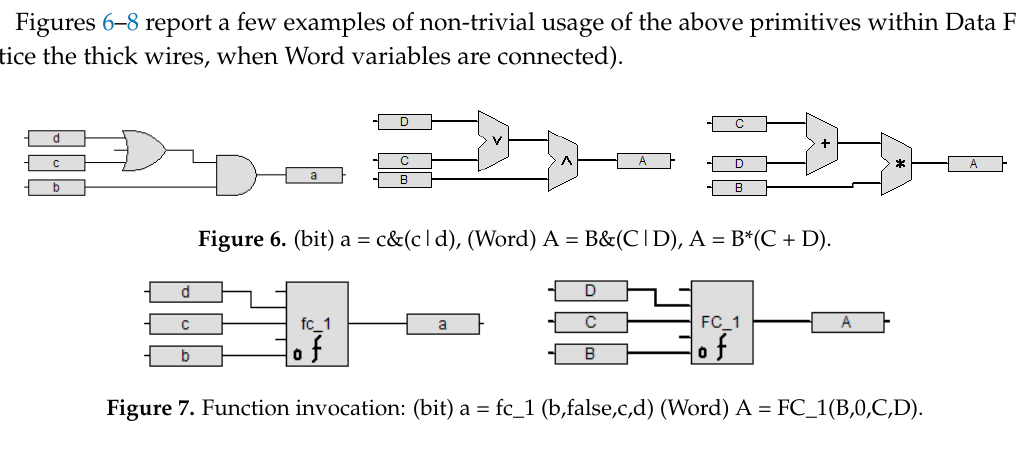
Figure 8. Examples of use of array subscripting: B = A [3]; c = d [E]; F [G] = H; K [2] = t0 [1]. Function invocation allows using, stateless, non-blocking functions, which map the set of input variables to its output. As already pointed out, the DF graphic formalism is completely free from the order in which the primitives are placed on the sheet; the behavior is only influenced by the type of primitive and their interconnections flowing from the “source” to destination variables. This aspect confirms the Model-Based nature of the TaskScript language: designers describe their systems as if they were designing physical pieces of hardware, following the very same rules, without need to add any further information; this is the reason why the declarative formalism was preferred over of the more “common” imperative one. With this choice the DF only describes pure combinatorial behaviors; this is different in imperative languages where the possibility to (a) assign variables (b) use them, (3) change their value (d)use them again, or the presence of control statements such as conditionals and iterators allows modeling a stateful behavior. The TaskScript Language makes a net separation: Control Flows abstract the sequential and parallel nature of the modeled system while each Data Flow abstracts a fragment of the combinatorial nature of the system. This distinction adds clarity to models while leaving complete freedom to designers. While systems more sequential in nature could/should be modeled giving emphasis to the CF, the very same system could be modeled with less Steps in the CF, with Steps possibly having larger associated Data Flows; the tradeoff among the above cases is left to designers. External Functions allow to encapsulate fragments of imperative behavior without breaking the DF rules for cases where a declarative implementation would be inefficient or difficult to read; for example: finding the maximum value in an array, calculate the current value for a PID